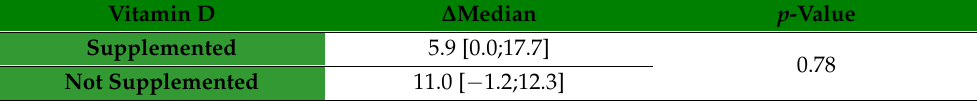
Table 6. Delta Median for vitamin D levels in the supplemented and the non-supplemented.